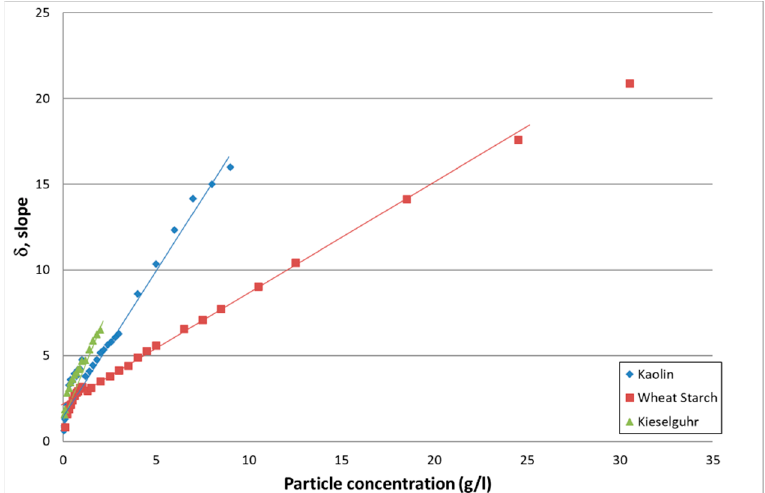
Figure 5. Evolution of the slope as a function of the particle type and concentration.